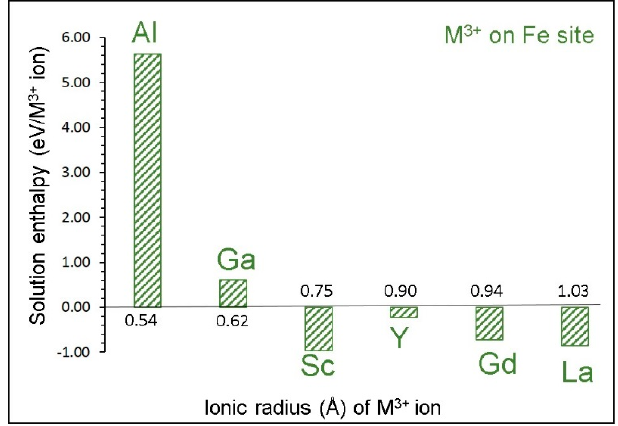
Figure 5. Solution enthalpies calculated for R 2 O 3 (R = Al, Ga, Sc, Y, Gd and La) with respect to the M 3 + radius in an octahedral coordination .